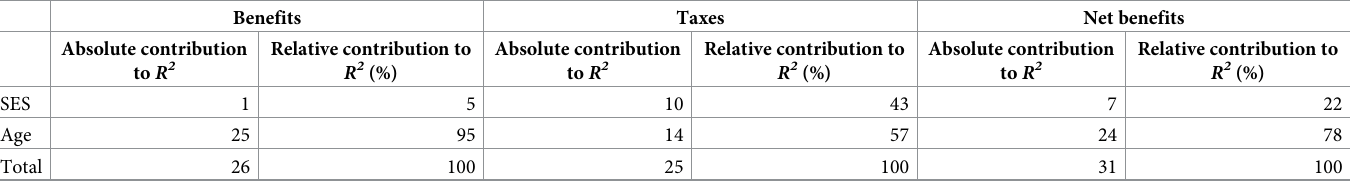
Table 2. Contribution to the explained variance by age and SES for benefits, taxes, and net benefits (Shapley-value decomposition of the R 2